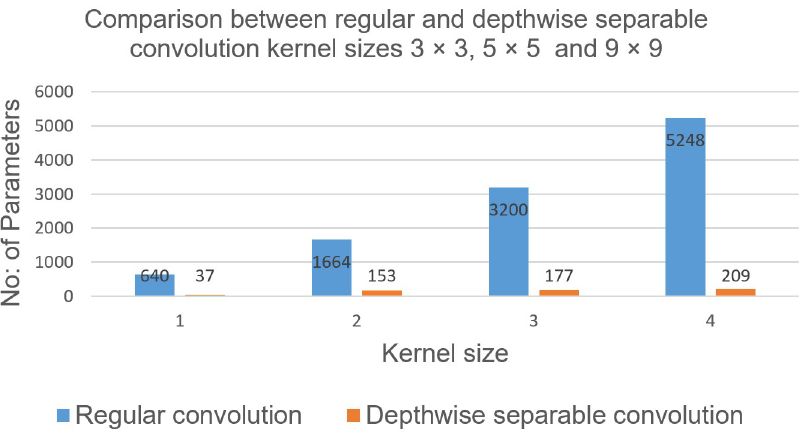
Fig 9. Complexity comparison between the regular convolution kernel versus the depthwise separable convolution kernel.